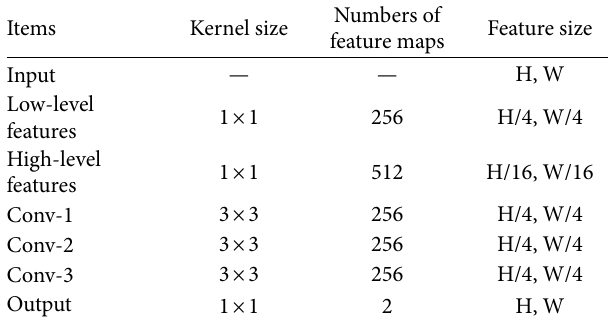
Table 1: Details of upsampling module